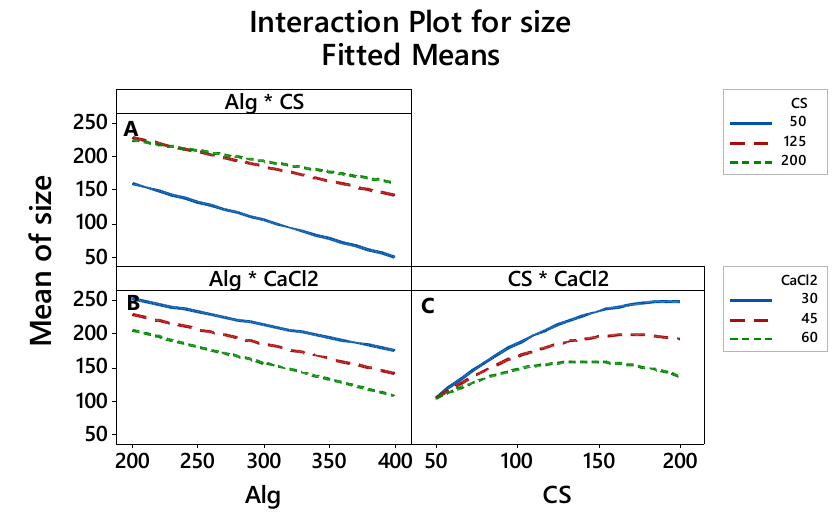
Figure 7. Interaction effects of factors on the particle size. 308 Polymers 2019 , 11 , x FOR PEER REVIEW